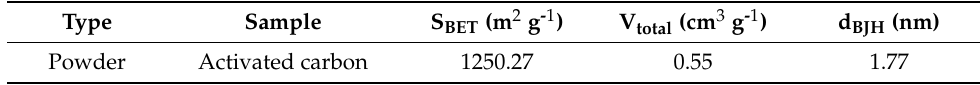
Table 1. Physical properties of activated carbon powder.